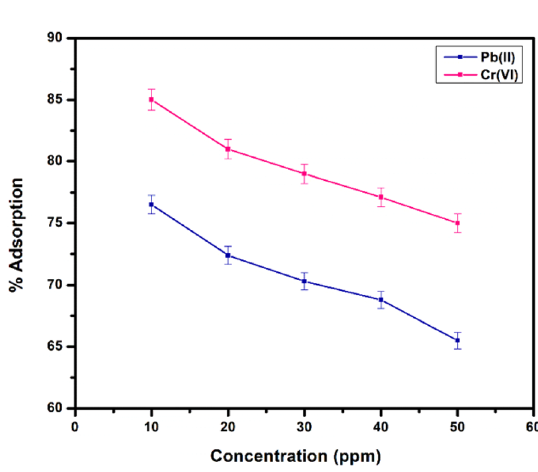
Figure 11. Adsorption of metal ions as a function of pH.